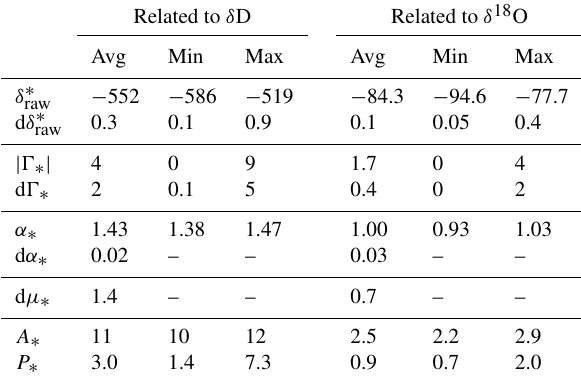
Table 2. Order of magnitude of the parameters involved in the error propagation calculation for δ D and δ 18 O. “avg”, “min” and “max” are the mean, the minimum and the maximum value of the param- eter over the campaign. A stands for accuracy and P for precision. Every parameter is in ‰ except α ∗ and d α ∗ , which are dimension- less. Related to δ